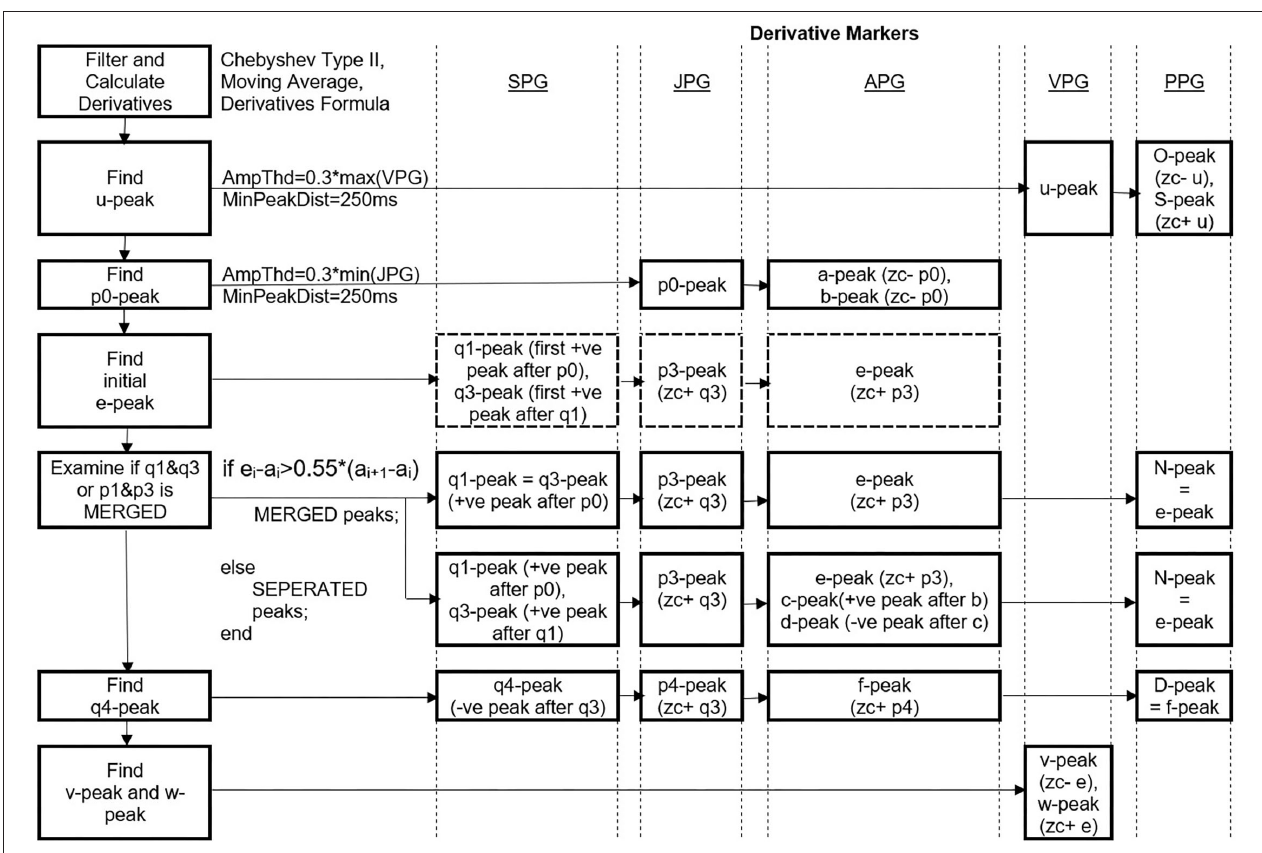
FIGURE 4 | Peak detection steps using DMM. *Ampthd, Amplitude threshold; MinPeakDist, Minimum peak distance; zc-, zero-crossing before; zc + , zero-crossing after, –ve, negative, + ve,